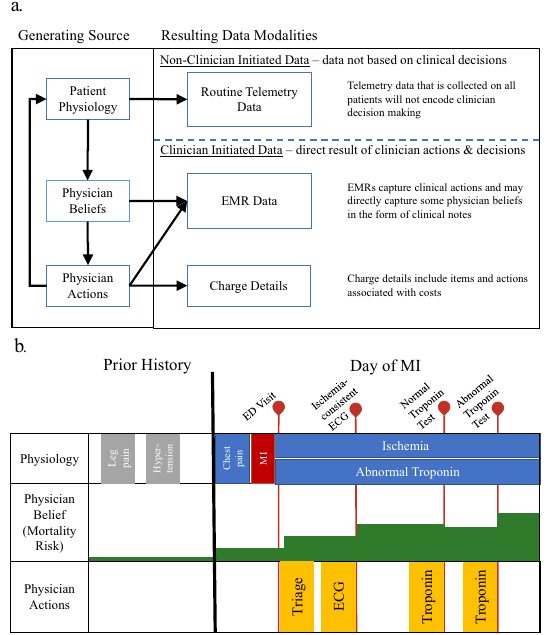
Fig. 1 Clinician-initiated data alone is a fi ltered representation of patient physiology. a Clinician-initiated and non-clinician-initiated data are distinguished by their proximity as readouts of patient physiology, as well as the presence of the expertise of the clinician. b Physician actions are a re fl ection of their beliefs regarding a patient, which are formed through examination of patient physiology.